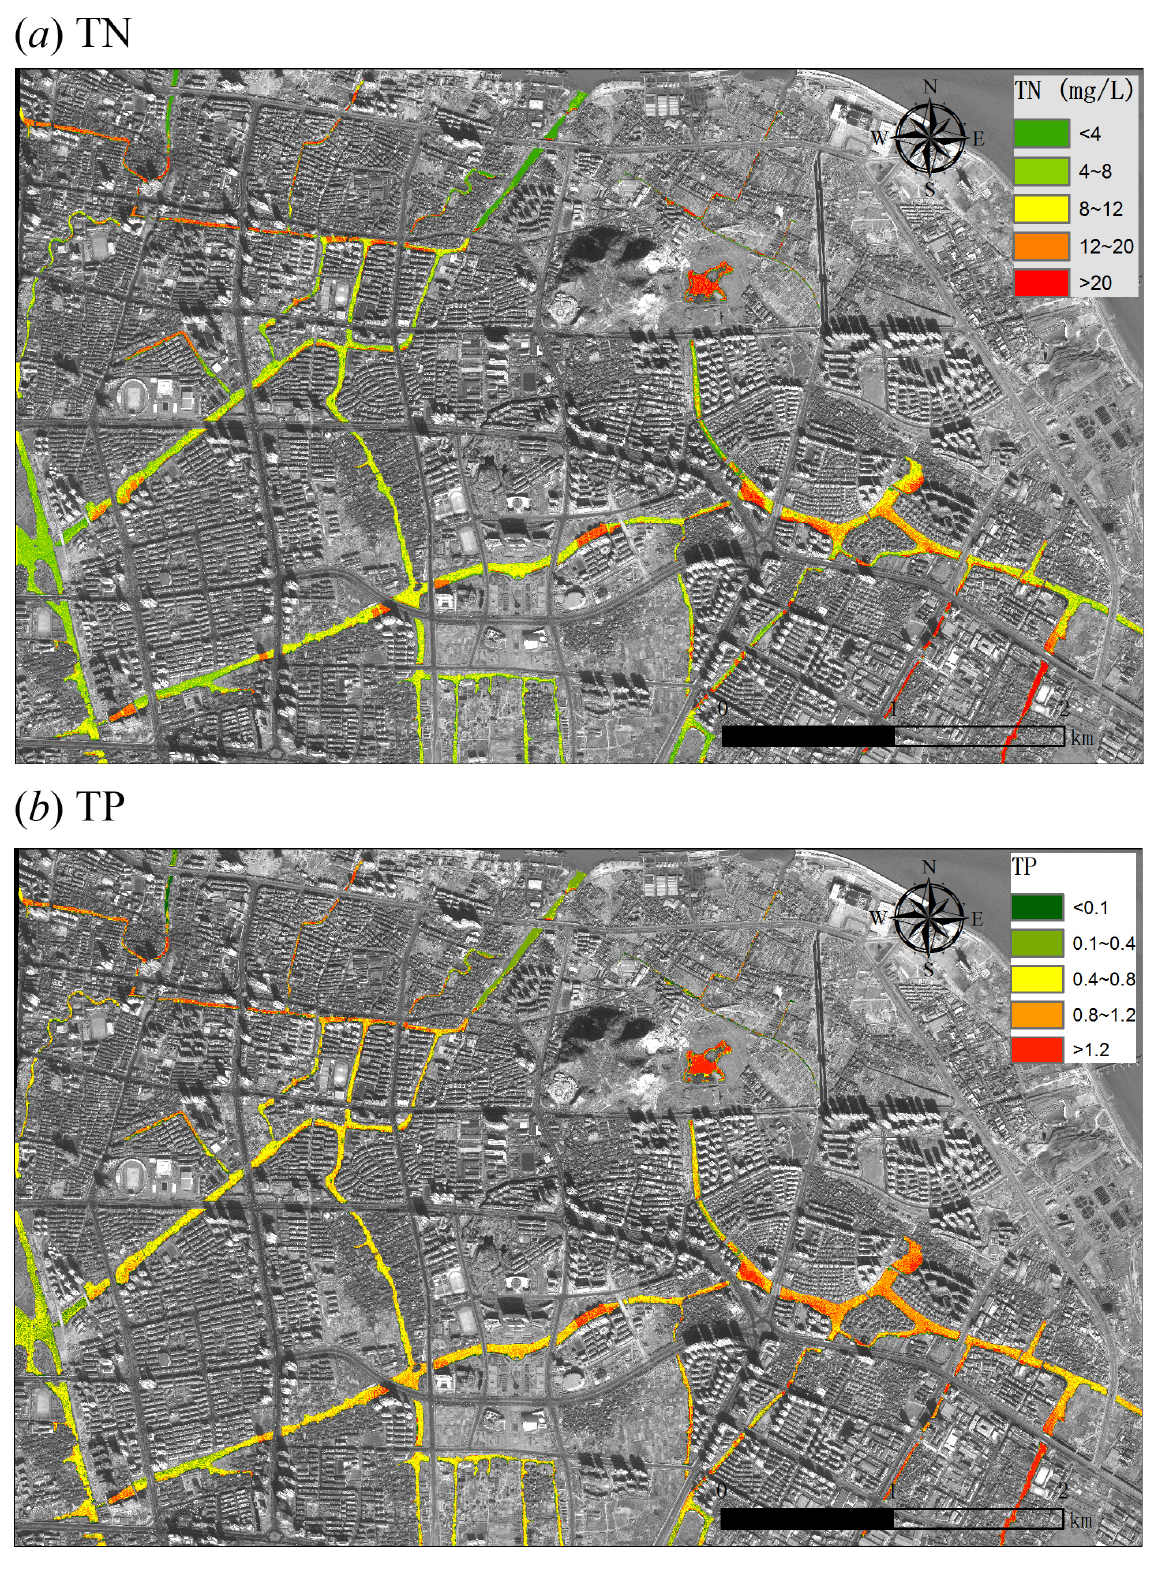
Figure 8. Spatial distribution maps of ( a ) TN and ( b ) TP over lower reaches of WRT River. Figure 7a shows the predicted TN concentration distribution in Lake Cihu on 14 November 2011, with an average value of 1.63 mg/L and a standard deviation of 0.56 mg/L. The highest TN concentration is observed in the middle of the north of Lake Cihu, ranging from 1.3 to 2.4